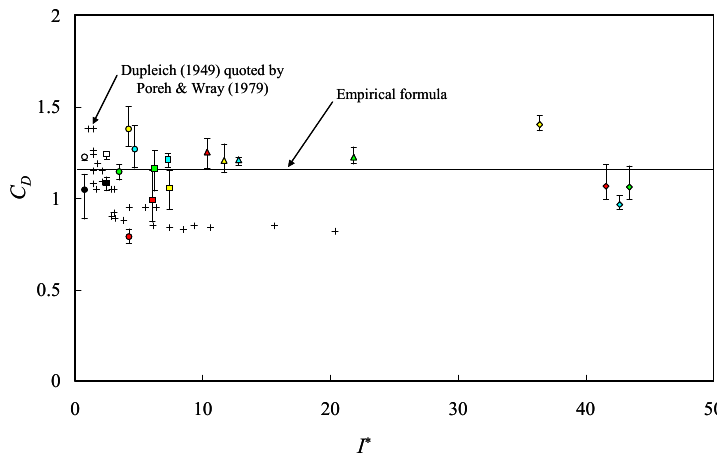
Fig. 8 Drug coefficient C D versus inertia moment ratio I * , for λ = 0.3, AR = 10, C = 7.2 × 10 1 − 1.6 × 10 3 and I * = 0.75 − 43. Empirical formula is described as Eq. (22).